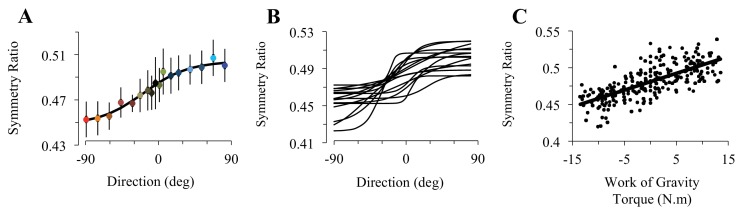
Experimental findings.(A) Experimentally recorded symmetry ratio, averaged across all subjects, is plotted as a function of movement direction. Similarly to the effort optimization hypothesis prediction (see panels D in Figure 1), experimental symmetry ratio is well fitted by a sigmoidal function (black curve). Error bars illustrate SD. (B) Fits of a sigmoid function to symmetry ratio as a function of movement direction for data from individual subjects. (C) Symmetry ratio as a function of Work of Gravity Torque (WGT). Each data point represents the mean of 12 trials for one subject moving in one direction (n = 255; 3060 trials total). It is noticeable that, similarly to the effort optimization hypothesis prediction (Figure 1E), arm kinematics (symmetry ratio) linearly correlates with gravity torque.